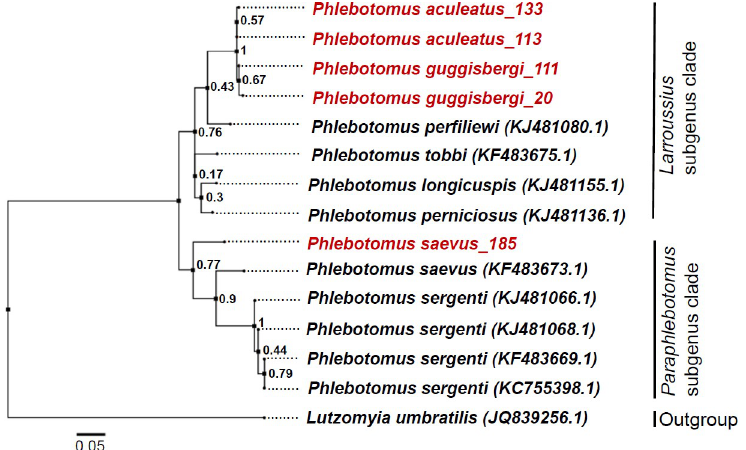
Fig 3. Phylogenetic analysis of the sandfly mitochondrial COI sequences by Maximum Likelihood method. The analysis was performed in MEGA v.7 based on the Kimura 2-parameter model. Bootstrap support values based on 1000 replicates are shown at the nodes. Other reference phlebotomine species belonging to different subgenera were included for comparison. The tree is drawn to scale, with branch lengths measured in the number of substitutions per site. Sample identities are shown in red while sequences retrieved from the GenBank are indicated in black. Representative CO1 sequences for each species are available in the GenBank under accession numbers: